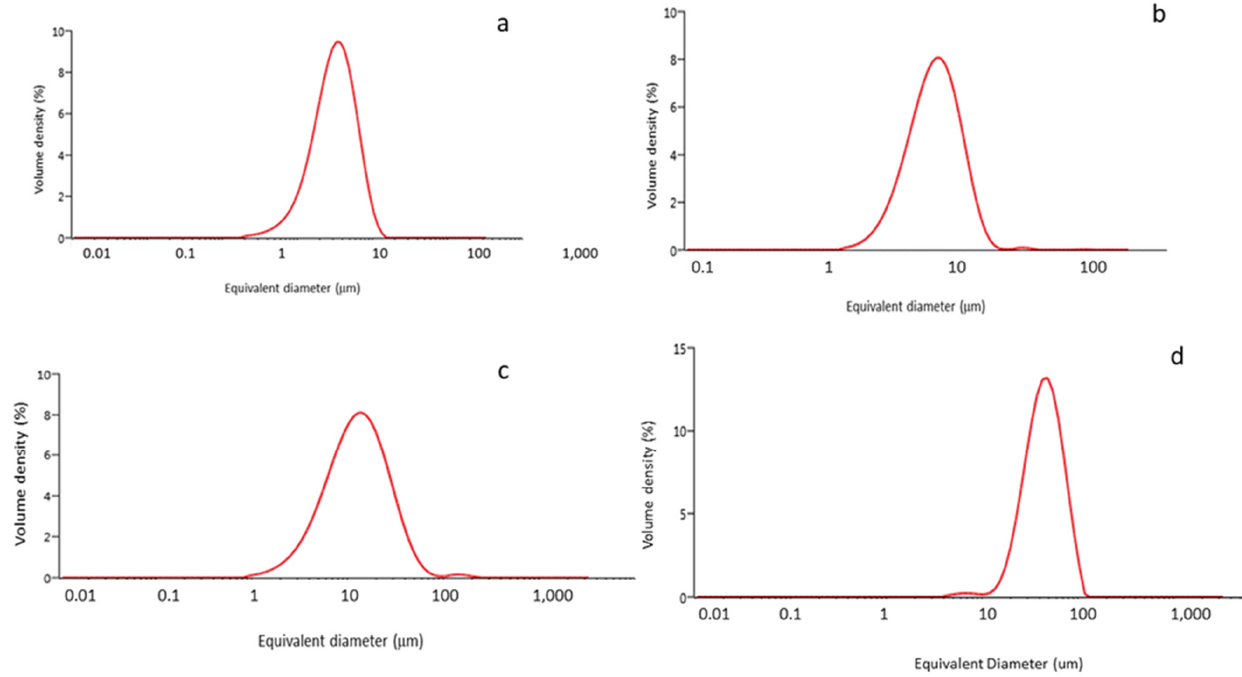
Figure 1. Granulometry curves for each class of particles: ( a ) 5 μ m; ( b )10 μ m; ( c ) 15 μ m; ( d ) 30 μ m.